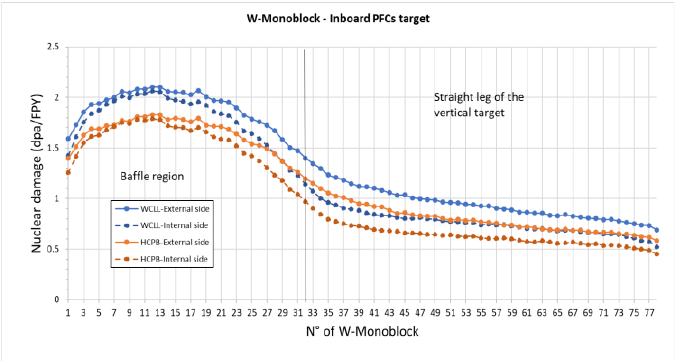
Figure 34. Inner poloidal profiles of the nuclear damage (dpa/FPY) on W-Monoblocks, comparing the values on the external and the innermost target sides, both for WCLL and HCPB blanket case.